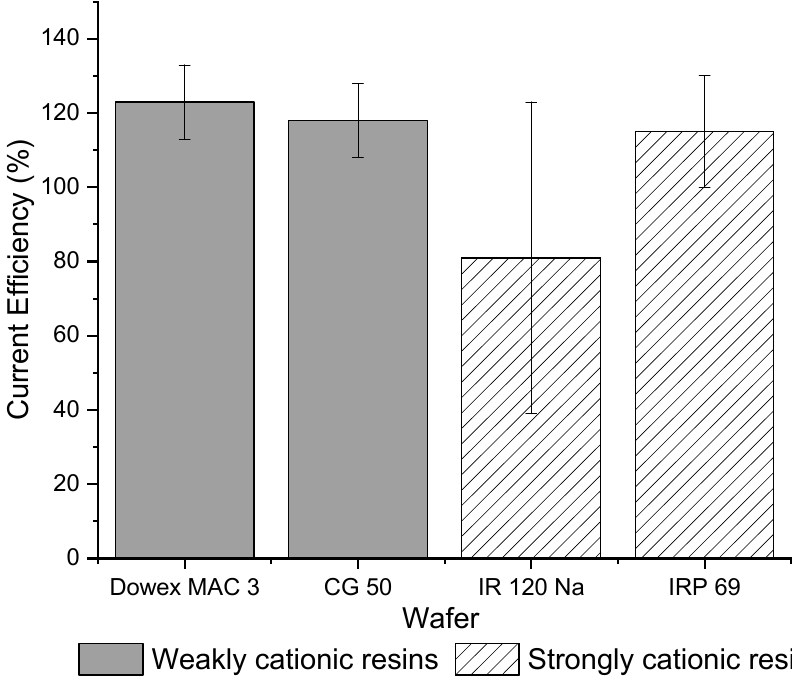
Figure 3. Overall current efficiencies for strong (IR 120 Na + and IRP 69) and weak cation exchange wafers (Dowex MAC 3 H + and CG 50).